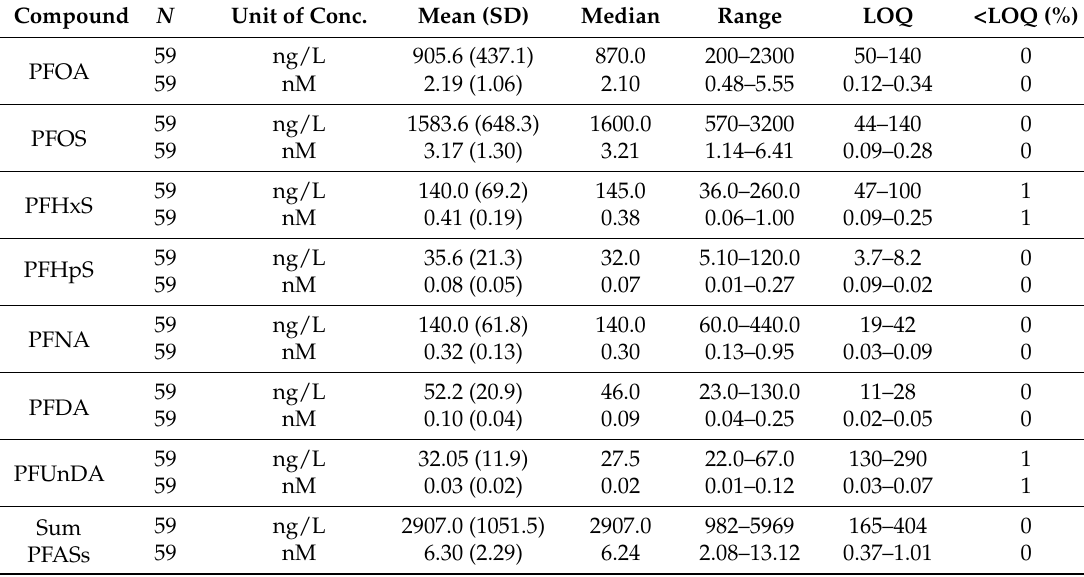
Table 1. Exposure levels of the various endocrine-disrupting chemicals in cord plasma, expressed in ng/L as well as